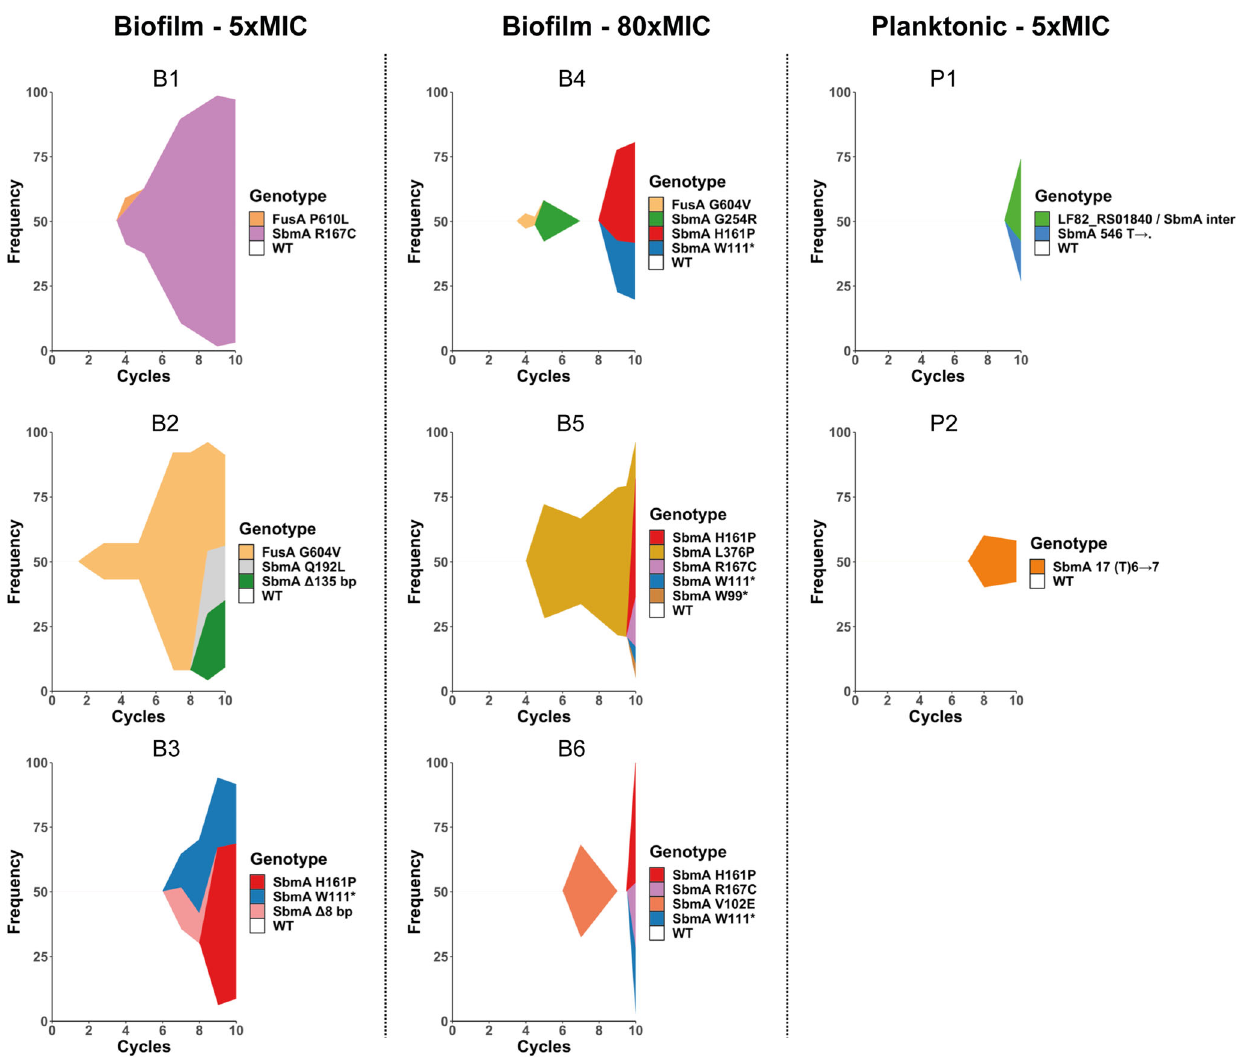
Fig. 4 Muller plots showing the dynamics of sbmA and fusA allele frequencies during the evolution of bio fi lm and planktonic populations subjected to intermittent amikacin treatment. An independent muller plot showing the dynamic of sbmA and fusA alleles frequencies over cycles of evolution is shown for each population. Every mutation is displayed with a unique colour through all plots. Due to the limit of detection, only mutations with frequency above 5% frequency are shown. Information regarding sbmA and fusA have been extracted from whole-population sequencing presented in supplementary Data